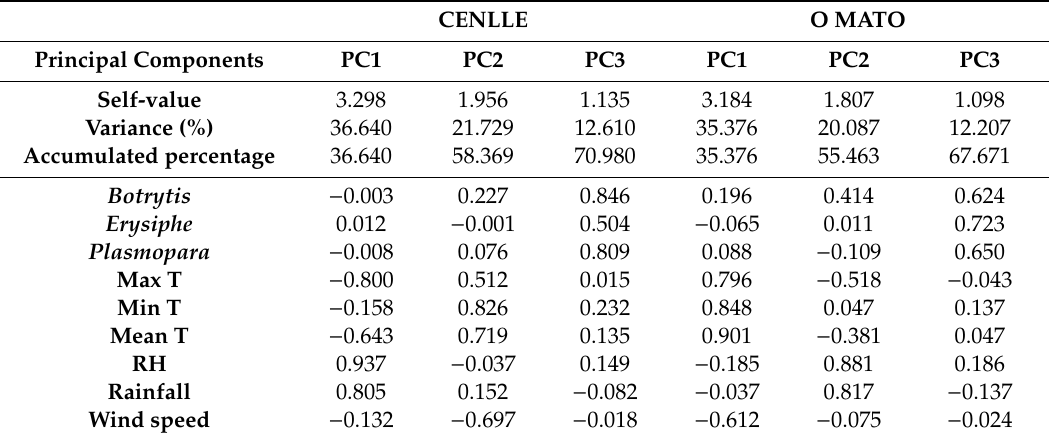
Table 5. Principal Component Analysis, principal component one, principal component two and principal component three. Confidence interval 95% ( p < 0.05).